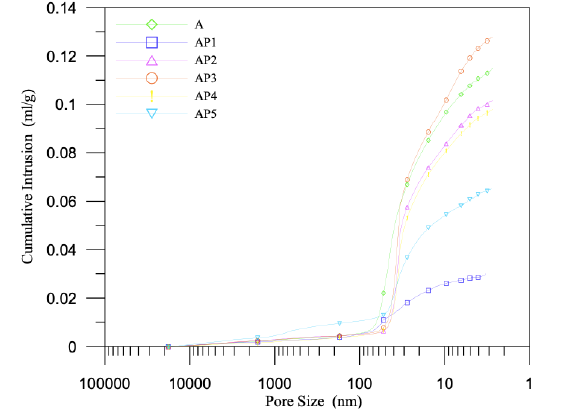
Figure 6. Relationship between the pore size and cumulative mercury intrusion of polyolefin fiber- reinforced concrete specimens (without